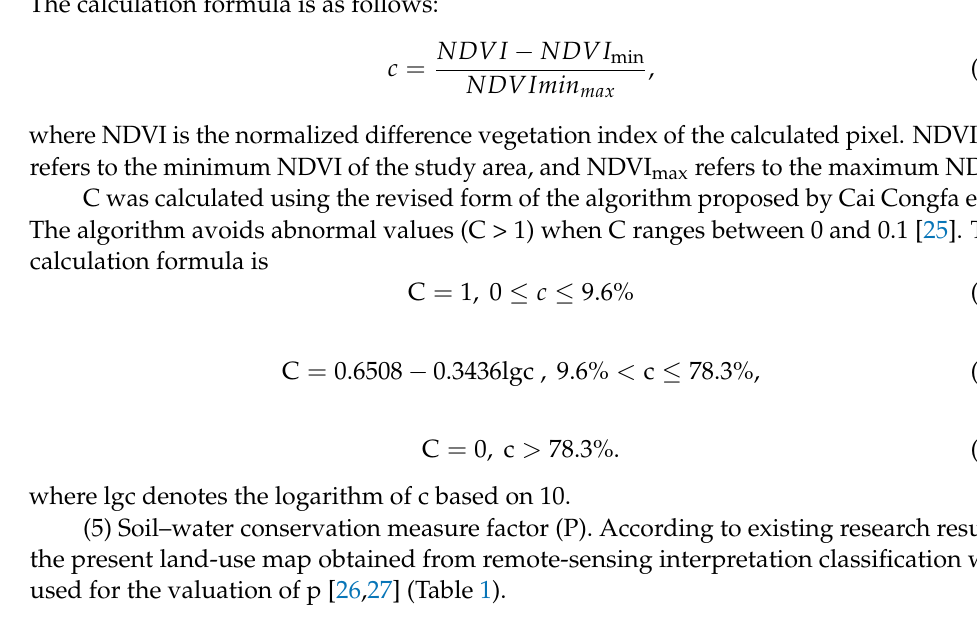
Table 1. Land use p factor